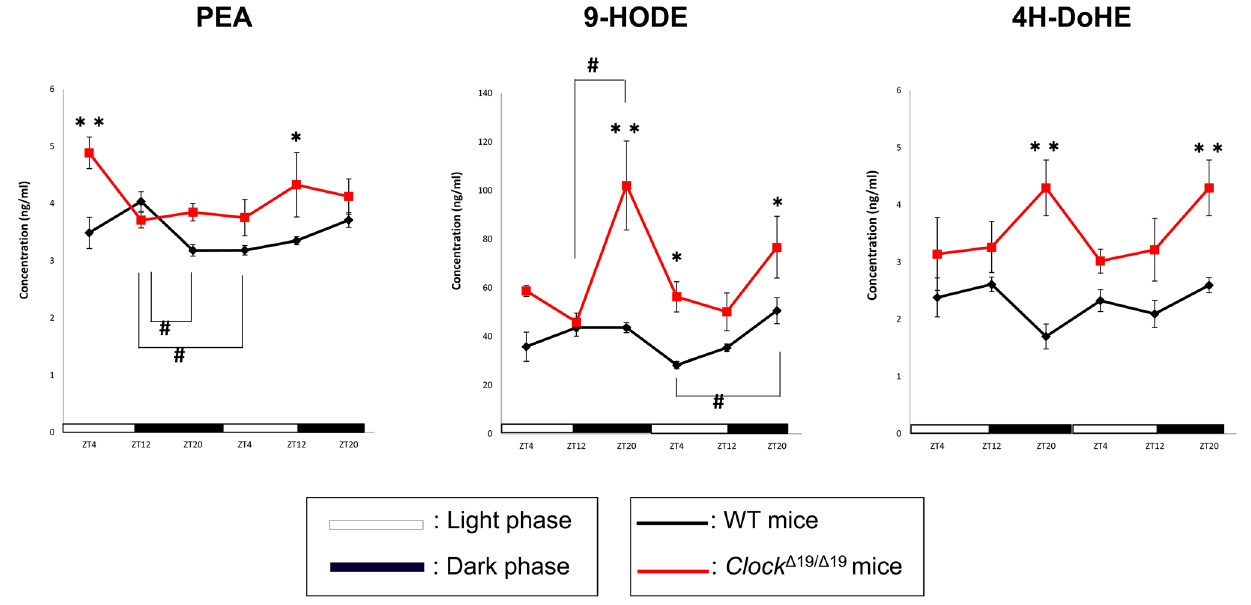
Figure 1. Levels of fatty acid metabolites in mouse serum. Data are presented as means ± standard error (SE). Four mice were used at each time point. One-way ANOVA with Bonferroni’s post hoc test was used to compare the differences in time-dependent change in each group. Two-way ANOVA with Bonferroni’s post hoc test was used to compare the differences at each time-point between WT and Clock Δ19/Δ19 mice. p < 0.05 was considered significant. # p < 0.05 using one-way ANOVA with Bonferroni’s post hoc test. * p < 0.05; ** p < 0.01 using two-way ANOVA with Bonferroni’s post hoc test. ZT, Zeitgeber